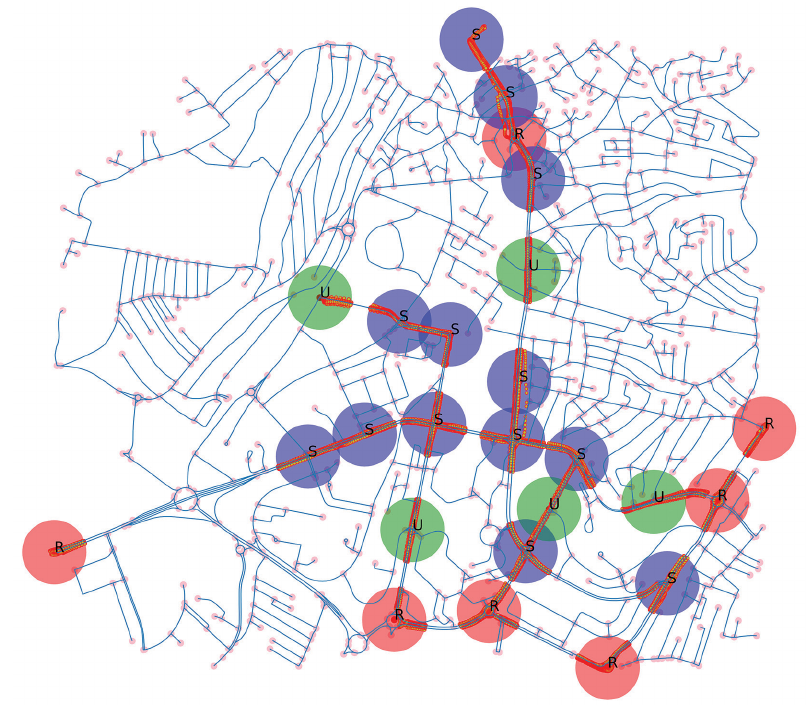
Figure 11. Selection of routes and intersections in